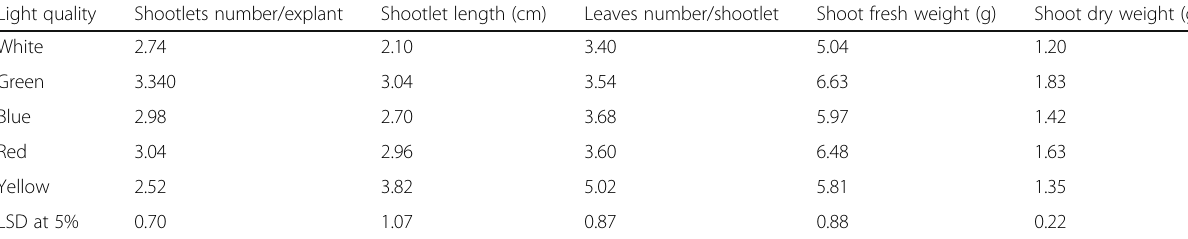
Table 2 Effect of light quality on shooting behavior of Cerationia siliqua L Light quality